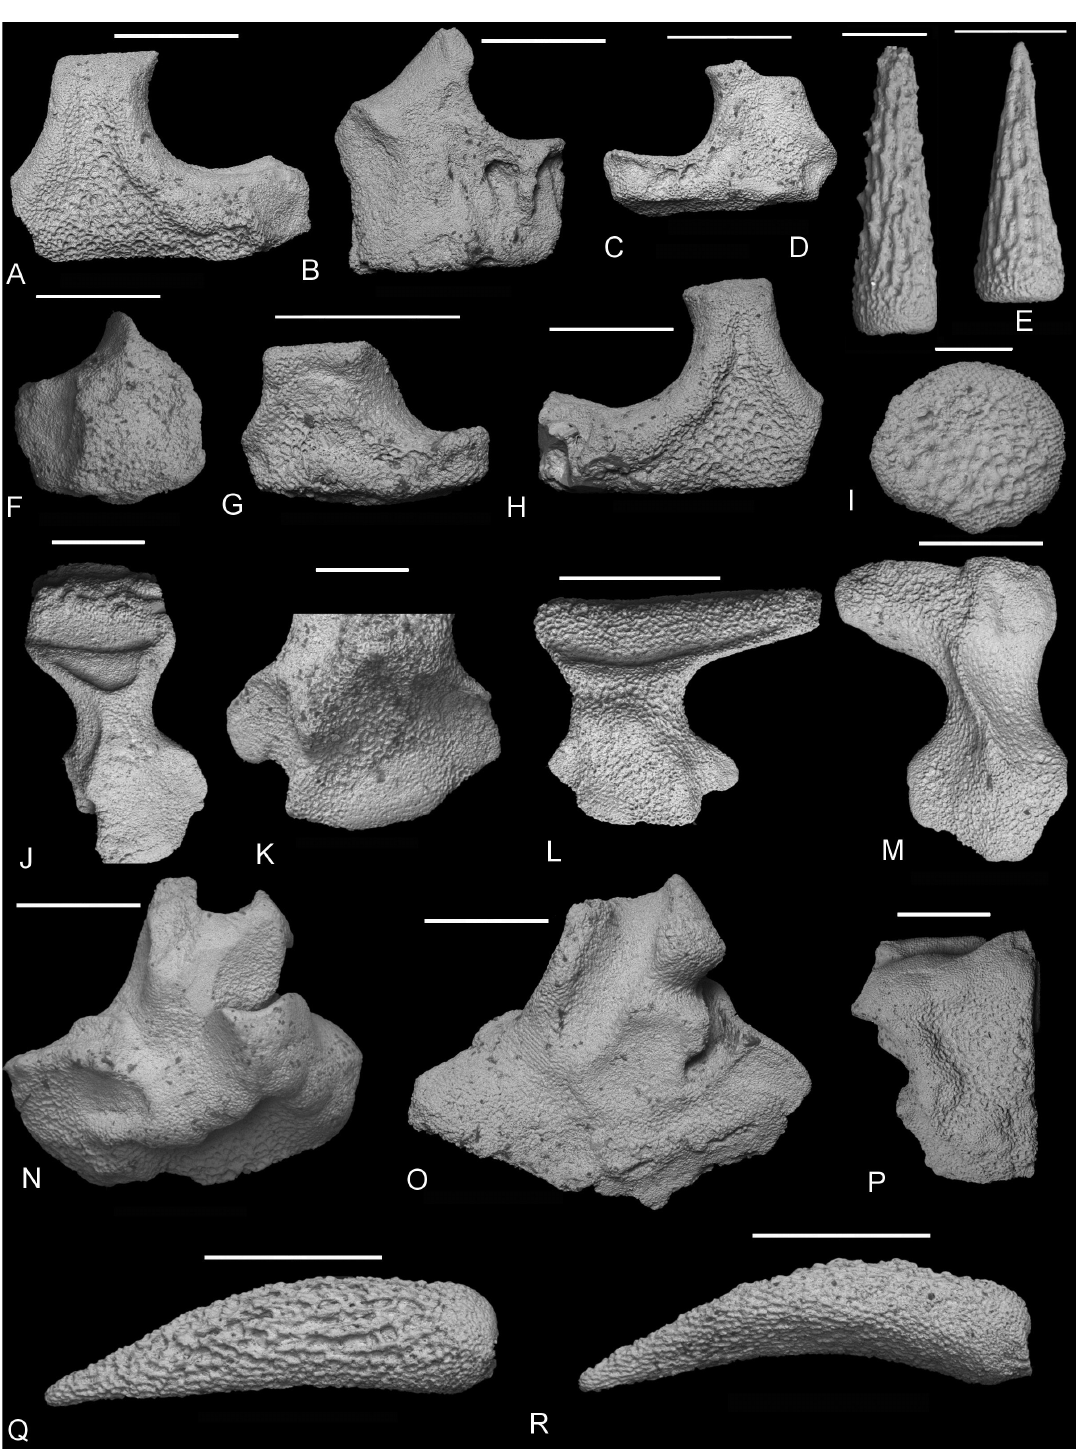
Fig. 10. Punkaster spinifera gen. et sp. nov. (holotype, NHMM JJ 11736). A–C, F–H . Adambulacral ossicles, in actinal (A, C, H) and abactinal (B, F–G) views. D–E . Abactinal or marginal spines. I . Abactinal ossicle. J–M . Ambulacral ossicles, in actinal (J – L) and abactinal (M) views. N–P . Oral ossicle, in radial (N), interradial (O) and actinal (P) views. Q–R . Large spines of uncertain position. Provenance: uppermost Maastrichtian, ca 12 m below K/Pg boundary, Kulsti Rende, Stevns Klint, eastern Denmark. Scale bars: A–C, F–R = 1 mm; D–E = 0.5 170